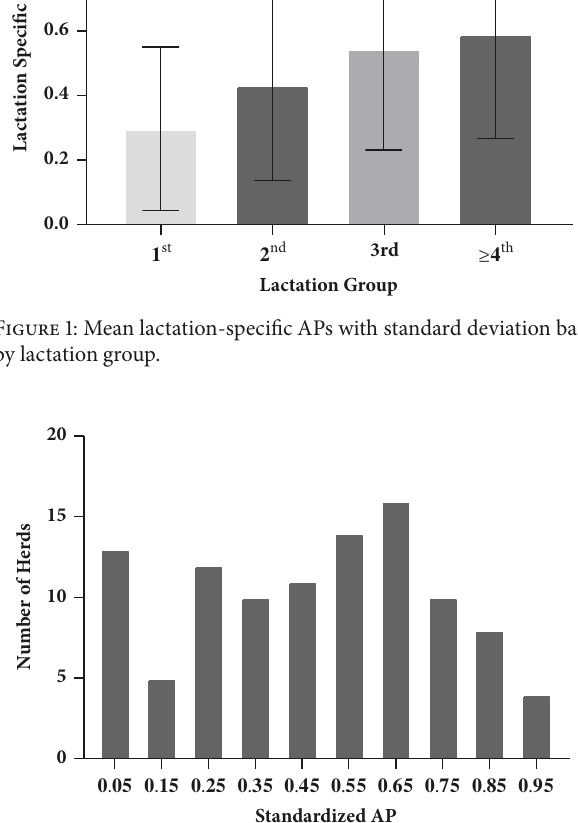
Figure 2: Frequency distribution of standardized AP; mean, 0.465; standard deviation, 0.27; histogram bin width=0.1; labels are at center point of bins.